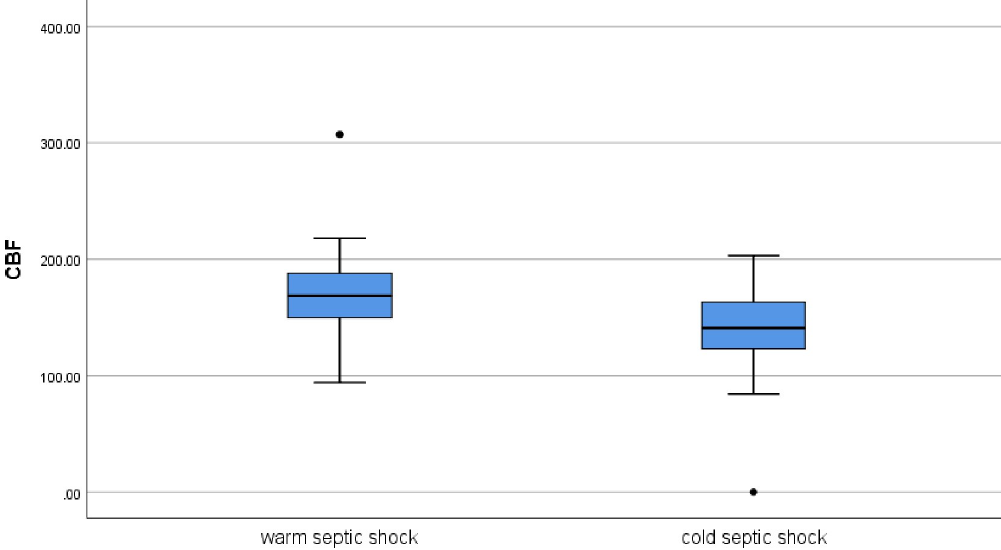
Fig 2. Difference in CBF between warm and cold septic shock.